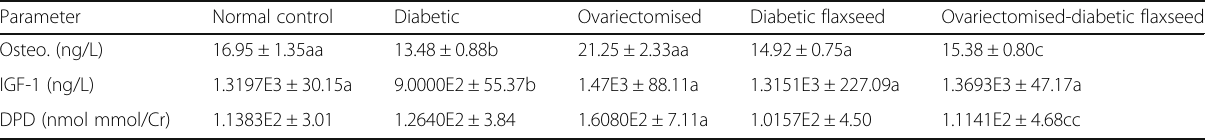
Table 2 Changes in bone formation and resorption parameters in the studied groups